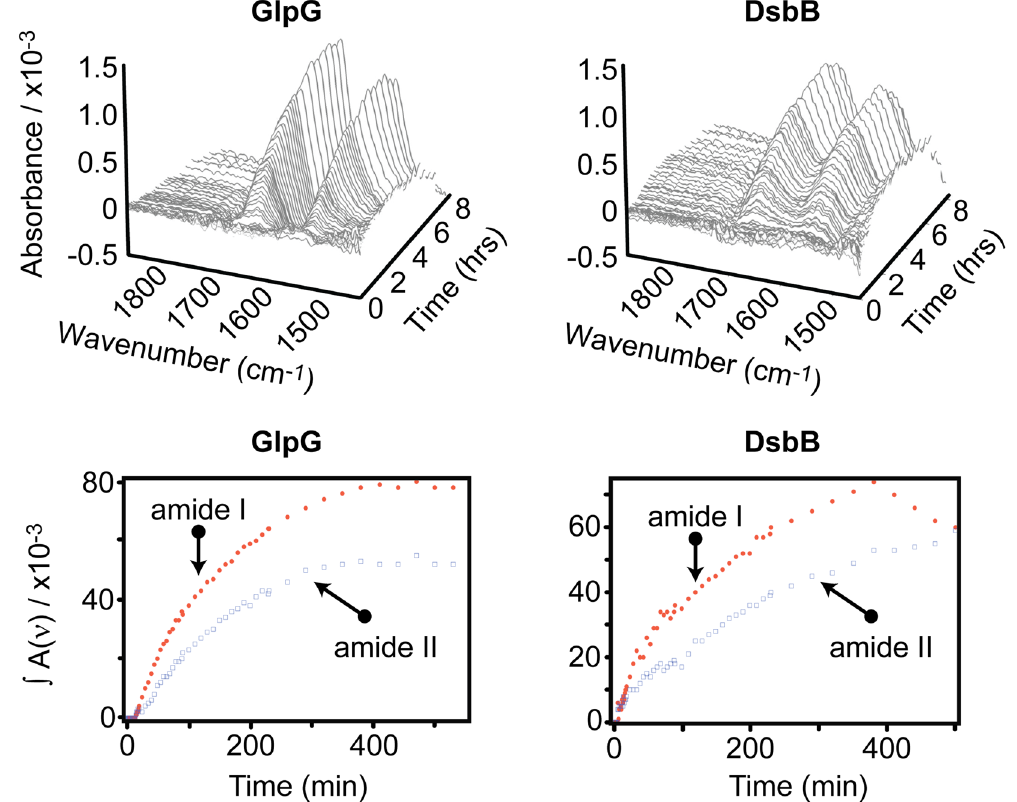
Figure 3. Time-resolved SEIRAS spectra of GlpG and DsbB. (Top row) Amide I and II peaks of GlpG (left) and DsbB (right) during cell-free synthesis and insertion into DMPC nanodiscs. (Bottom row) Time course of the amide I and amide II integrated peak